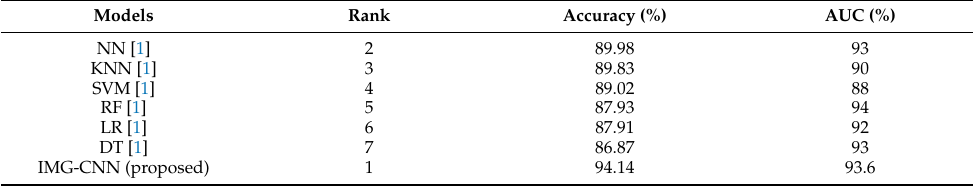
Table 10. Comparison of the performance evaluation metrics of the different models presented in previous studies and our proposed IMG-CNN model using the same clinical dataset.